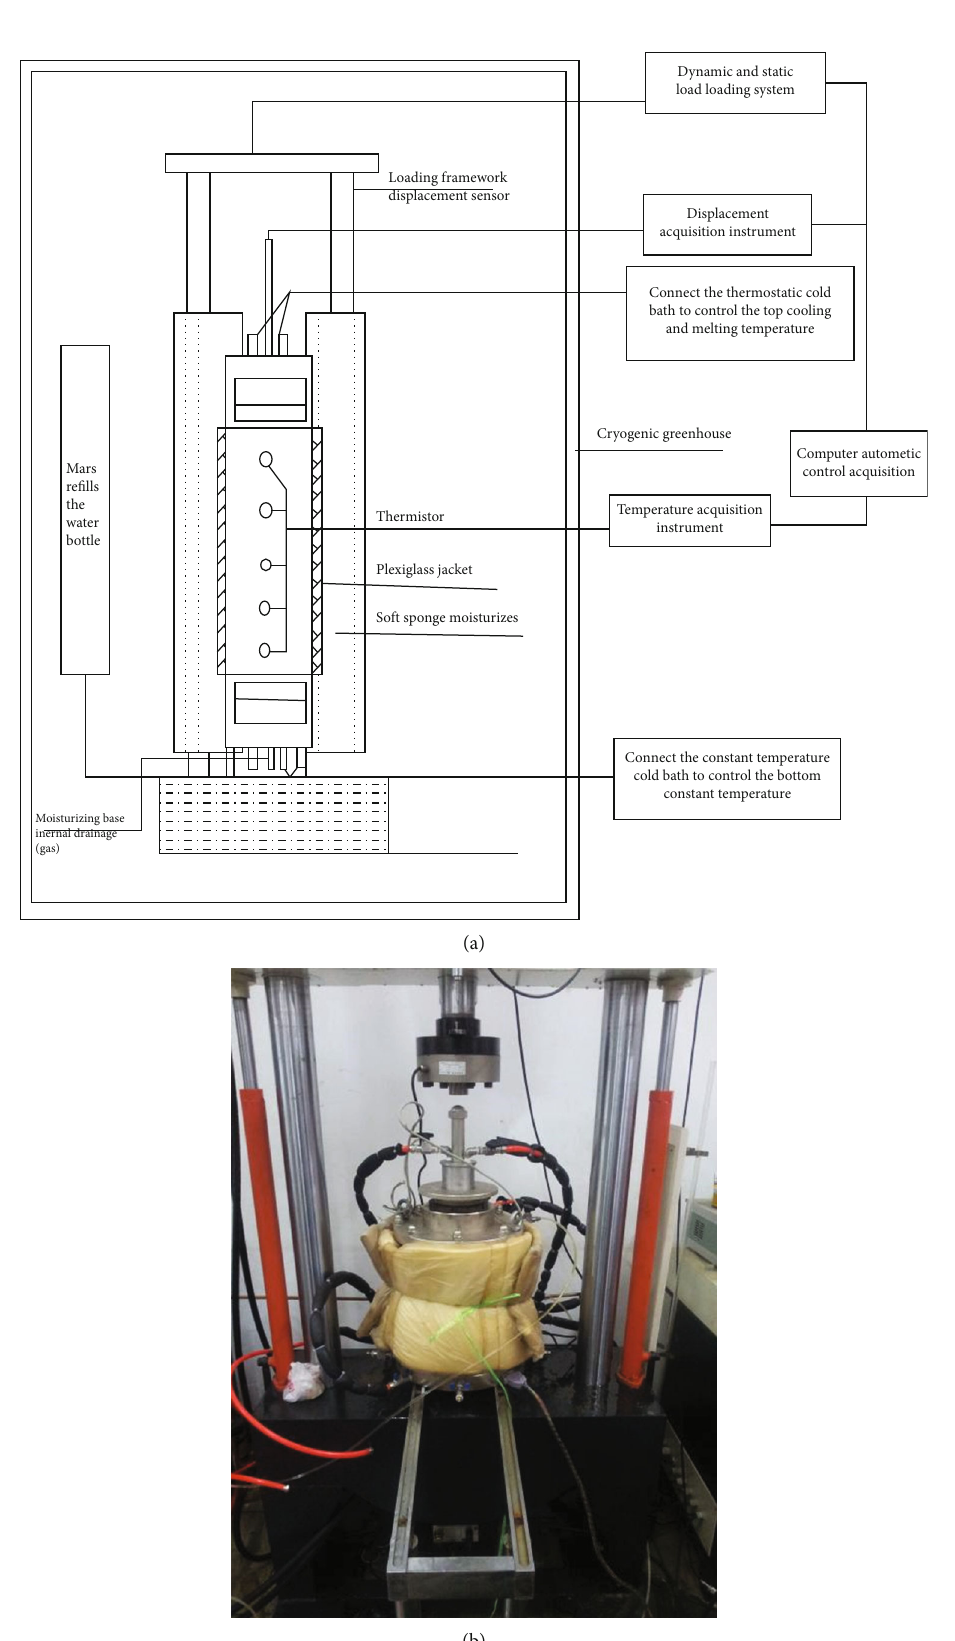
Figure 3: Instrument connection diagram. (a) The instrument connection plan. (b) The loading diagram of the dynamic load experimental